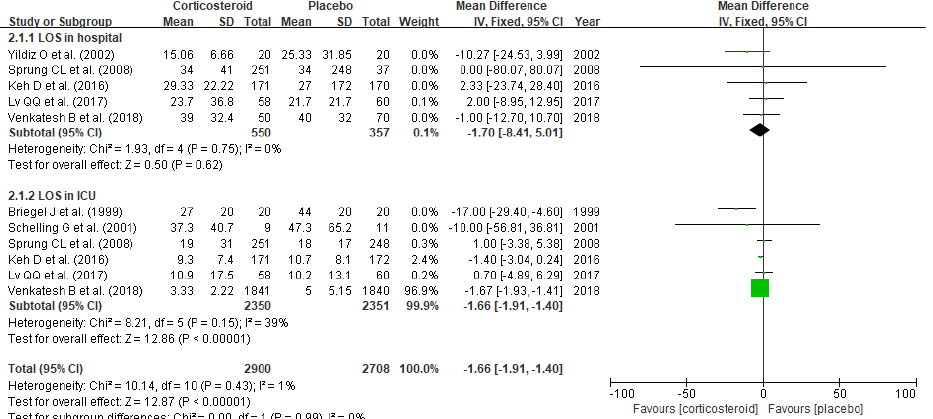
Figure 2. Forest plot of corticosteroid impact on mortality.